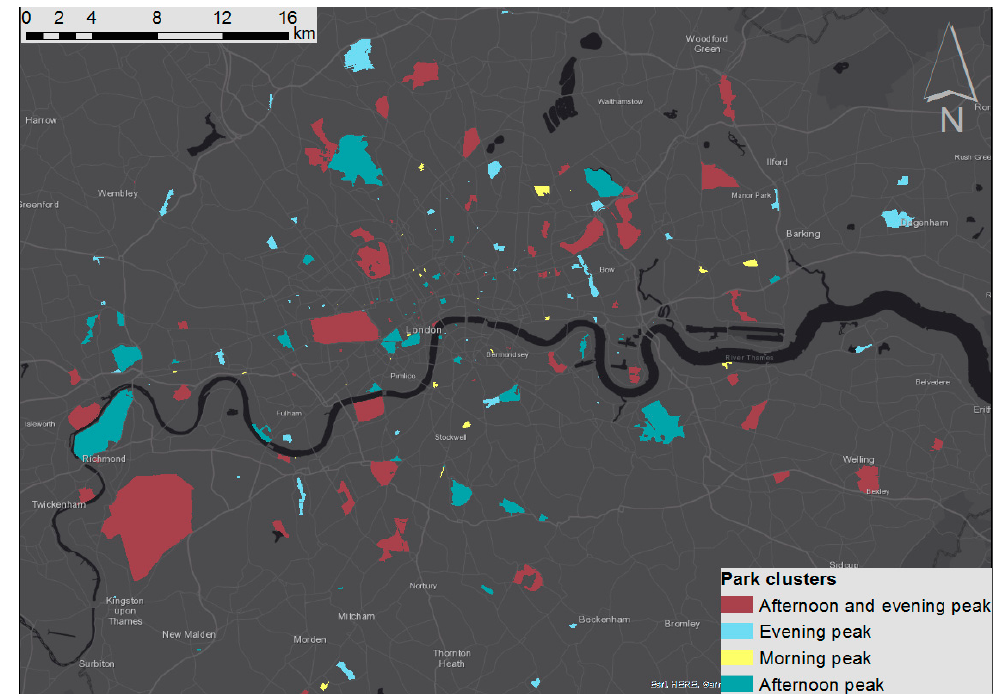
Figure 14. Park clusters according to visitors’ spatial behavior.